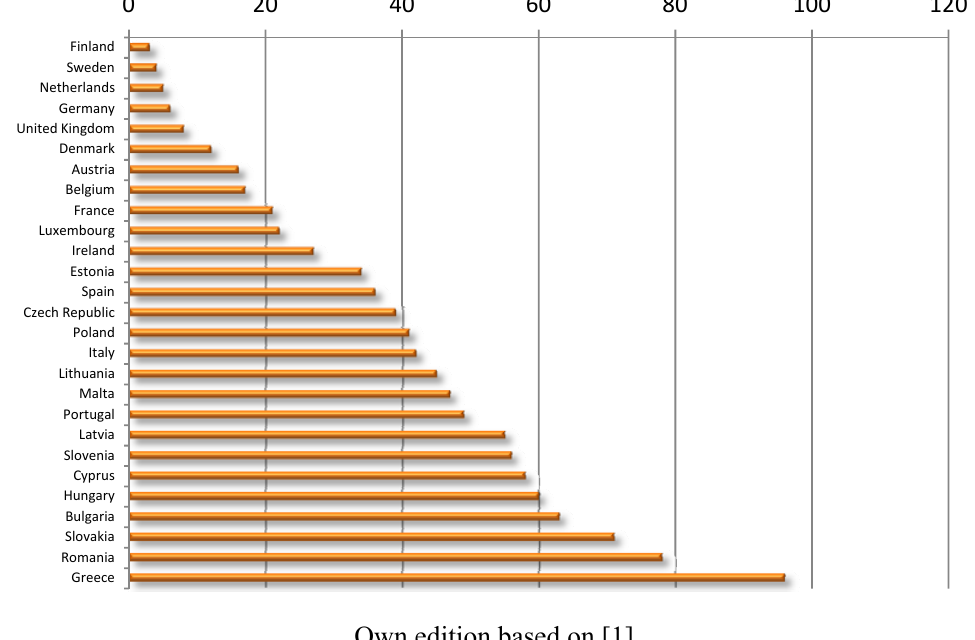
Own edition based on